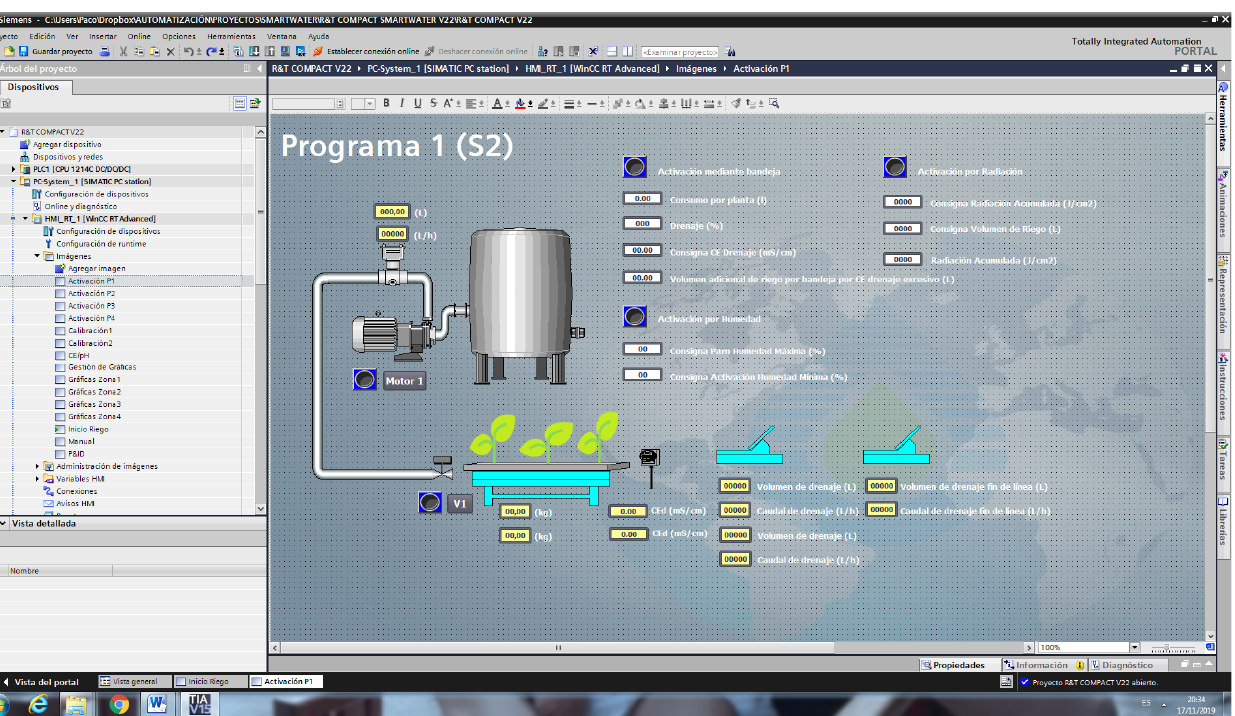
Figure 4. Screenshot of Human-Machine Interface of the SCADA